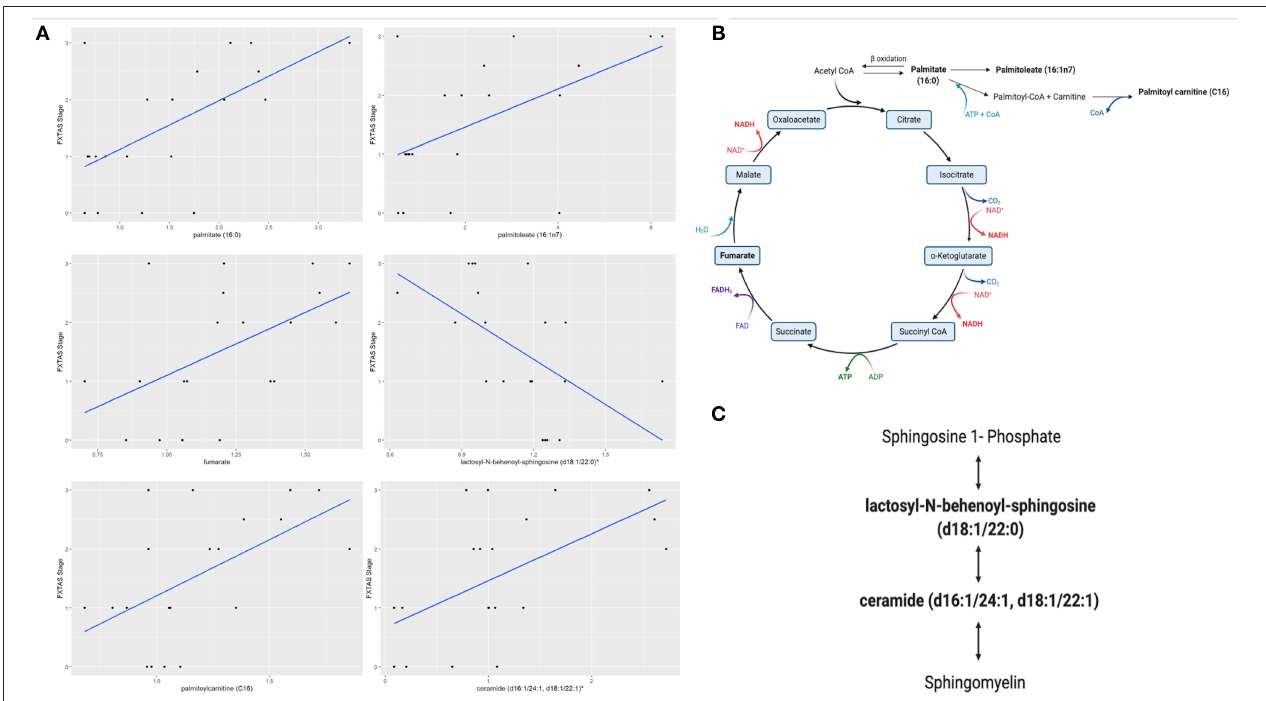
FIGURE 3 | Fatty acid and sphingolipids metabolism associated with FXTAS development. (A) Six identified metabolites in FXTAS associated with other neurodegenerative disorder, here the comparison with the FXTAS stage is shown; data are presented as FXTAS stage ( y- axis) and associated metabolite ( x -axis) by using scatter plots. (B) . Disturbance of fatty acid and lipids metabolism pathway is shown. (C) Sphingolipid metabolism pathway is shown. Bold metabolites, p ≤ 0.05 linked with the development of FXTAS. *The identity of these metabolites has not been officially confirmed based on the